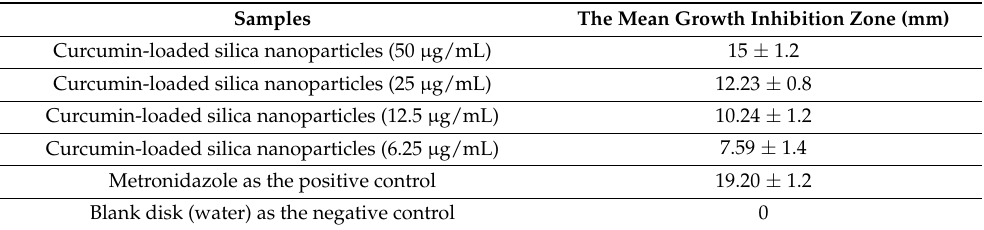
Figure 6. The mean growth inhibition zones of curcumin-loaded silica nanoparticles at different concentrations and in the control groups (negative control (N), positive control (P)). Table 1. The mean growth inhibition zone of curcumin nanoparticle and control groups.